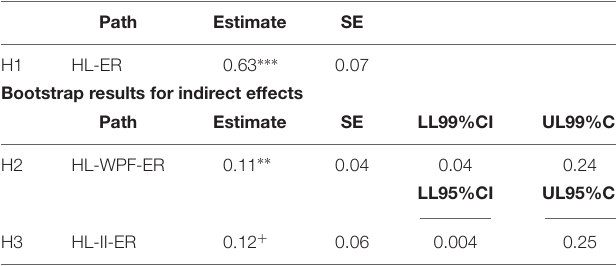
TABLE 4 | Standardized direct path coefficients of the hypothesized model (study